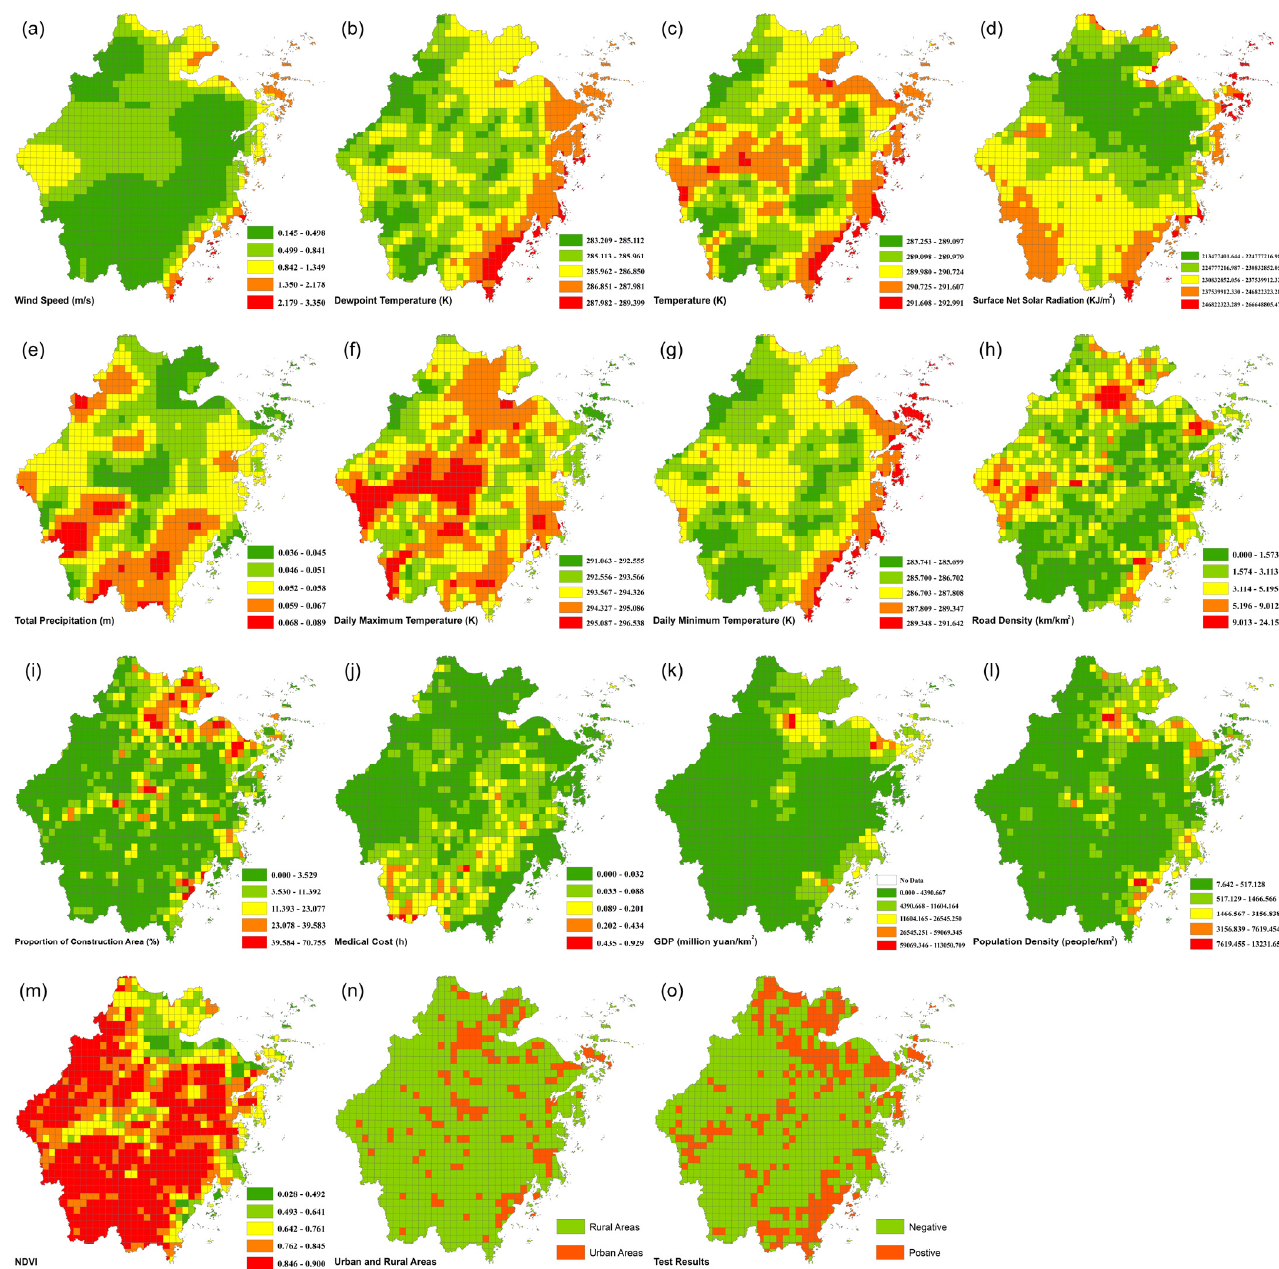
Figure 2. Spatial distribution of variables and detection results of V. parahaemolyticus , including ( a ) wind speed, ( b ) dewpoint temperature, ( c ) temperature, ( d ) surface net solar radiation, ( e ) total precipitation, ( f ) daily maximum temperature, ( g ) daily minimum temperature, ( h ) road density, ( i ) proportion of construction area, ( j ) medical cost, ( k ) GDP, ( l ) population density, ( m ) NDVI, ( n ) distribution of urban and rural areas, and ( o ) test results.